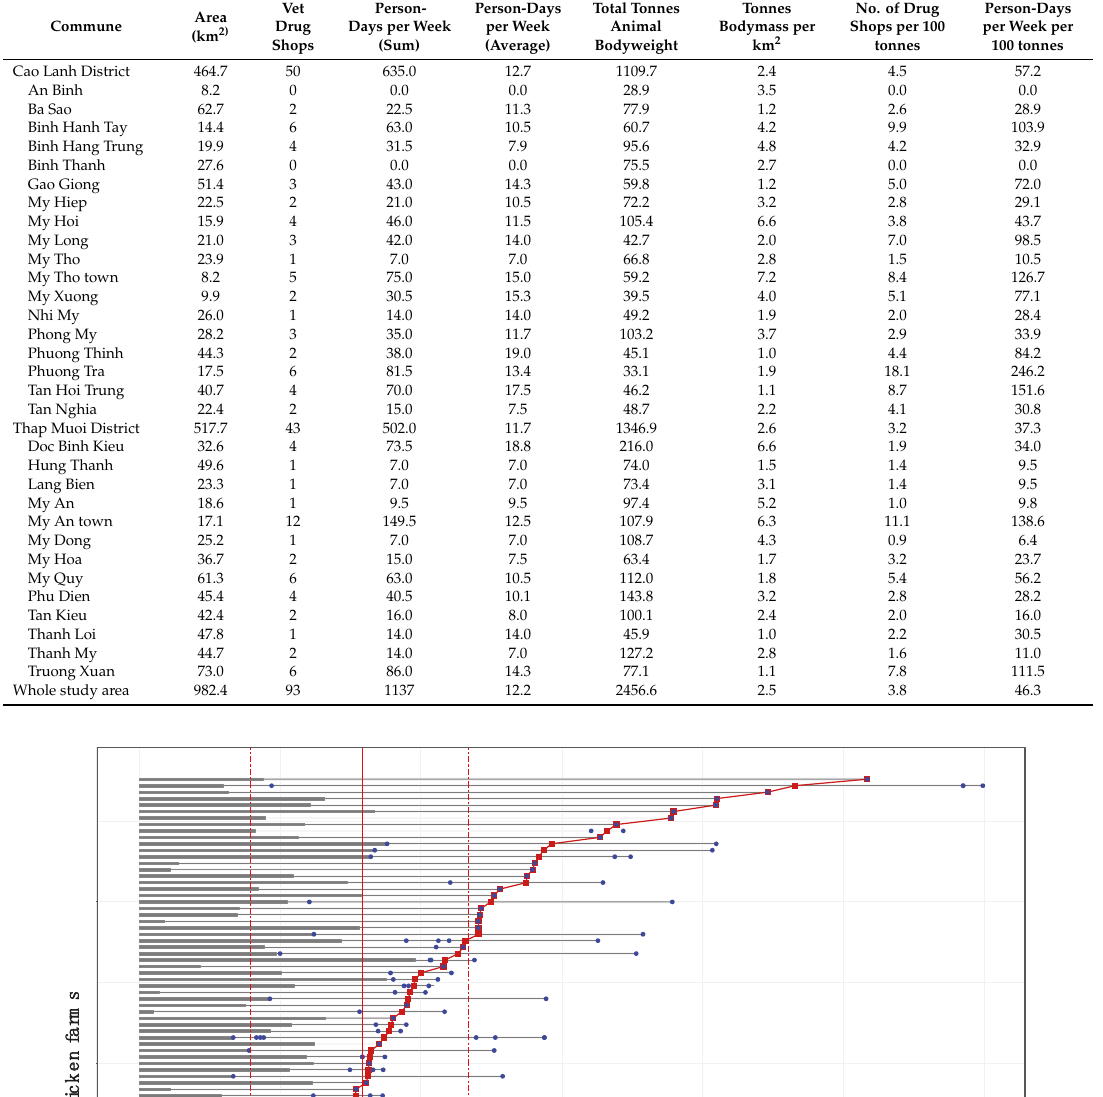
Person-Days per Week per 100 tonnes